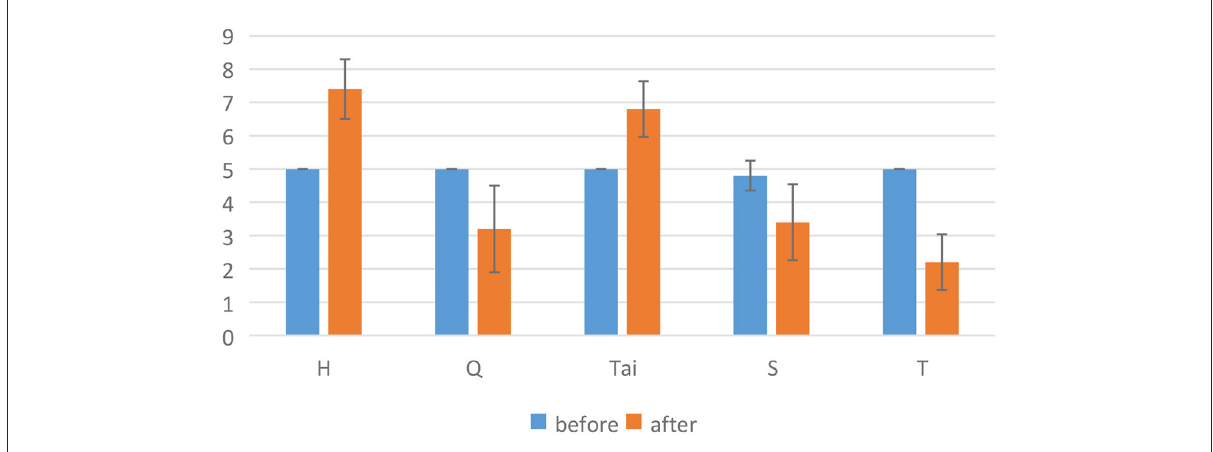
FIGURE1 Valence score of preliminary experimental evaluation.